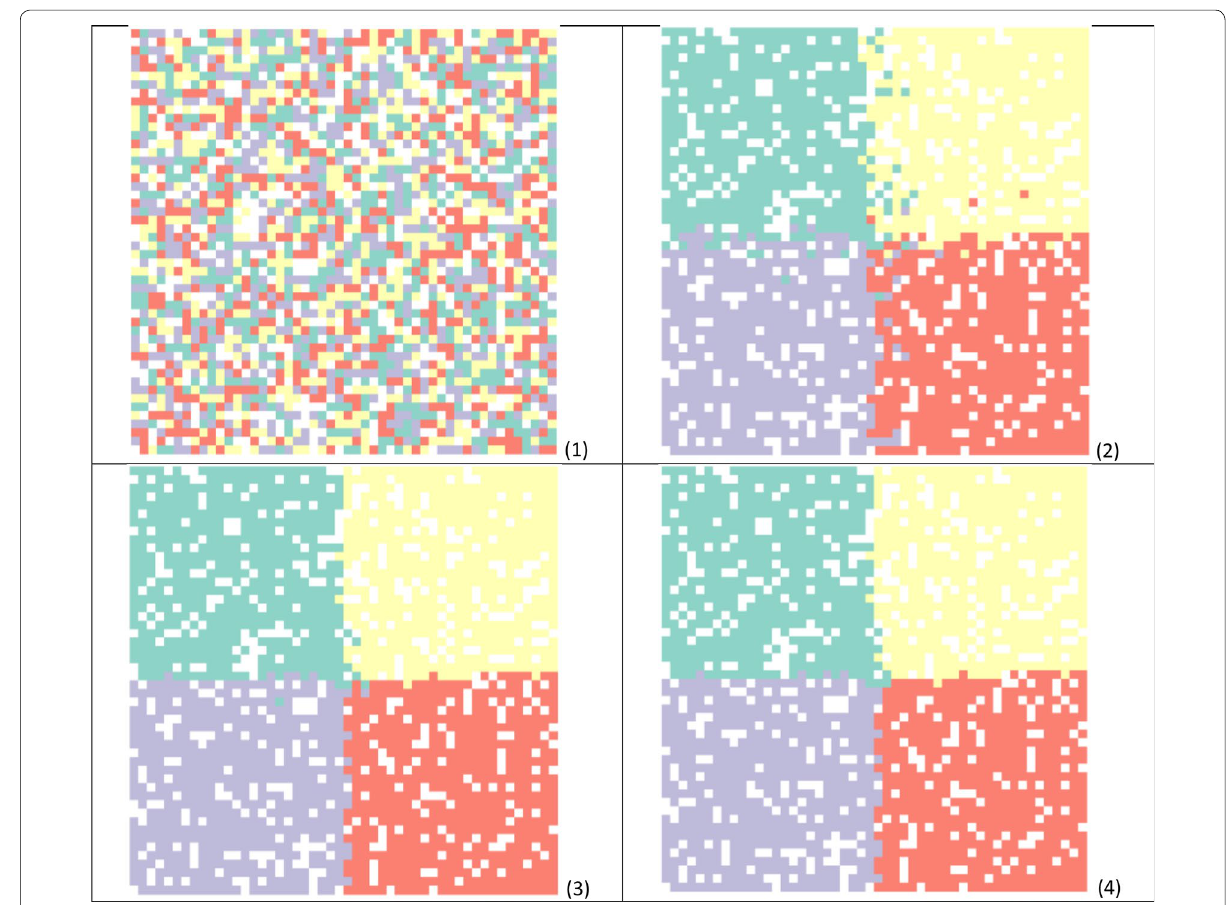
Fig. 4 Illustration of one simulation run for scenario 3 on a 50 50 grid. The numbers in brackets indicate the phase number of the simulation. In × this two-agent interaction scenario with the goal to be close to a tribe center the simulation terminates extremely fast at a stationary state